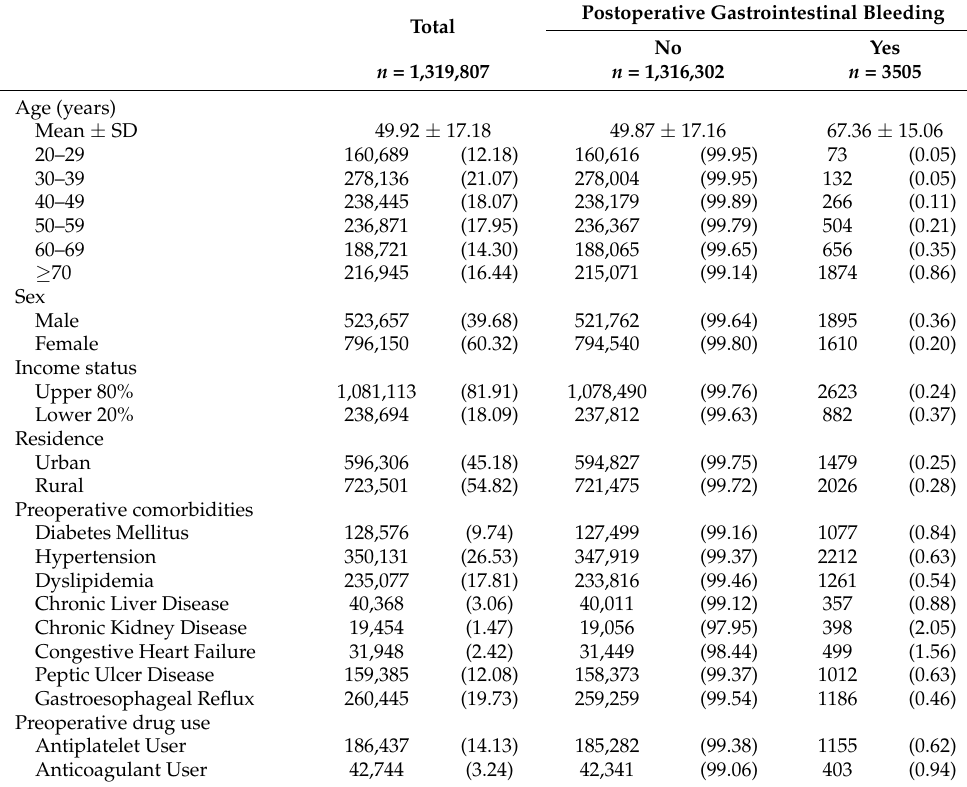
Table 1. Baseline characteristics of the study population ( n , %)